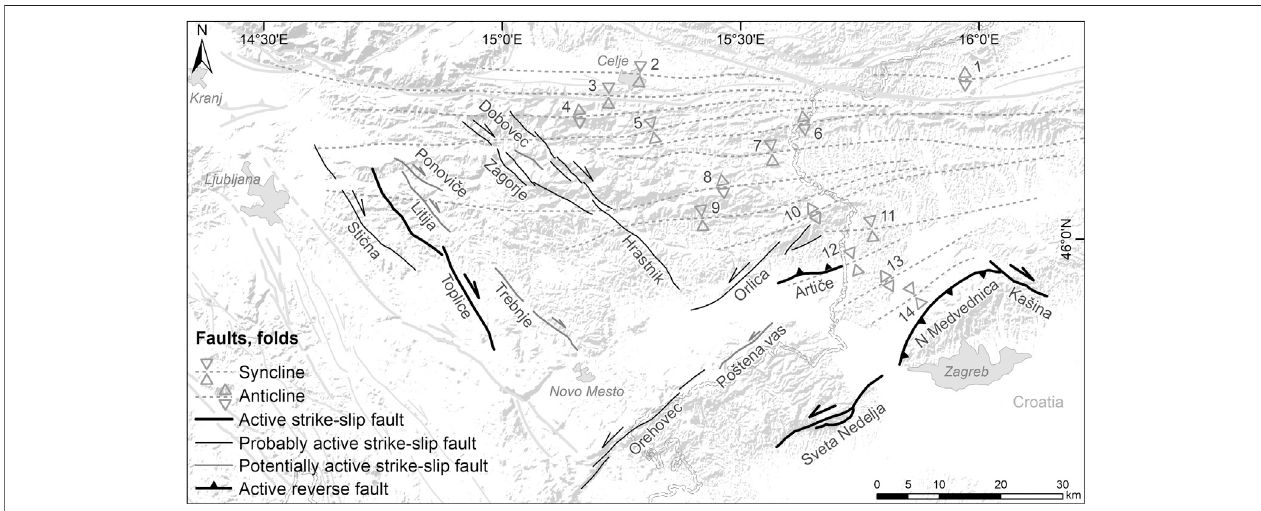
FIGURE 10 | Dextral strike-slip faults within the Sava compressive wedge (SCW), faults of the Balaton fault system (BFS) and the Sava folds (from Placer, 1998): 1-Pletovarje-Maceljanticline,2-Celjesyncline,3-Motniksyncline,4-Trojaneanticline,5-La ˇ skosyncline,6-Rudnica-Ivan ˇ cicaanticline,7-Planina-Desinicesyncline, 8 - Litija anticline, 9 - Senovo syncline, 10 - Orlica anticline, 11 - Bizeljsko-Zagorje syncline, 12 - Brezina syncline, 13 - Marija Gorica anticline, 14 - Brdovec